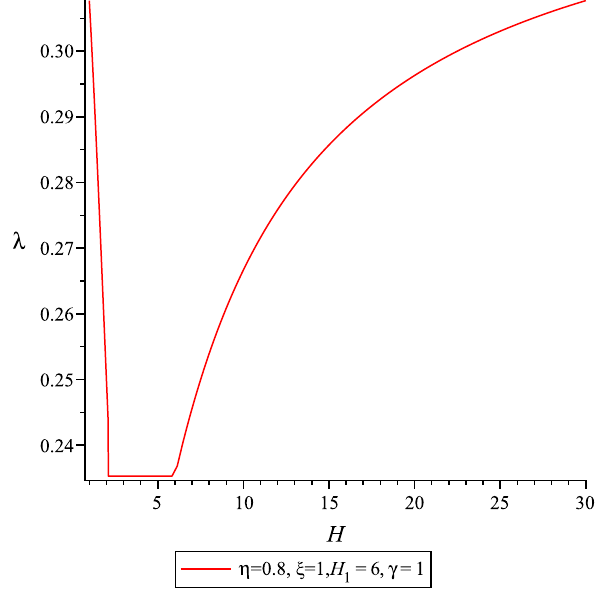
Fig. 2 Continuous evolution of the Rastall parameter λ